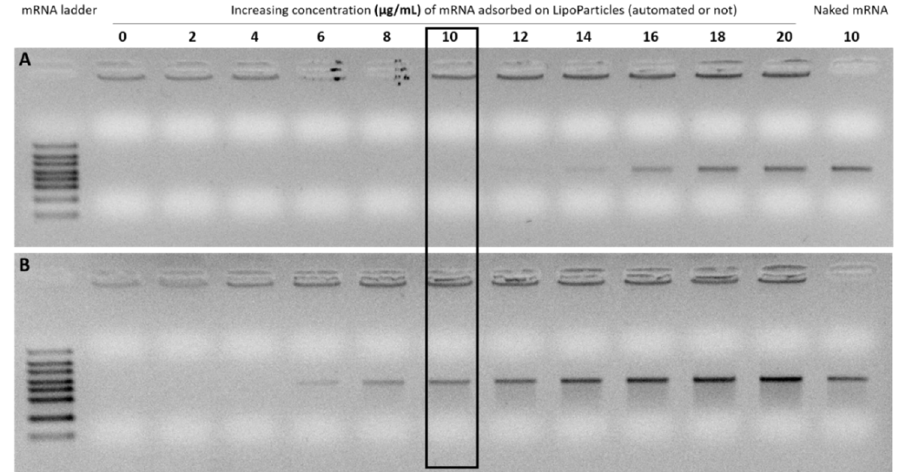
Figure 4. Determination of the amount of mRNA that can be adsorbed onto ( A ) LP and ( B ) LP auto using agarose gel electrophoresis assays. To this aim, formulations containing increasing concentra- tions of mRNA were prepared and directly deposited on 1% agarose gel. The black box represents the mRNA concentration used in the pLbL formulations.